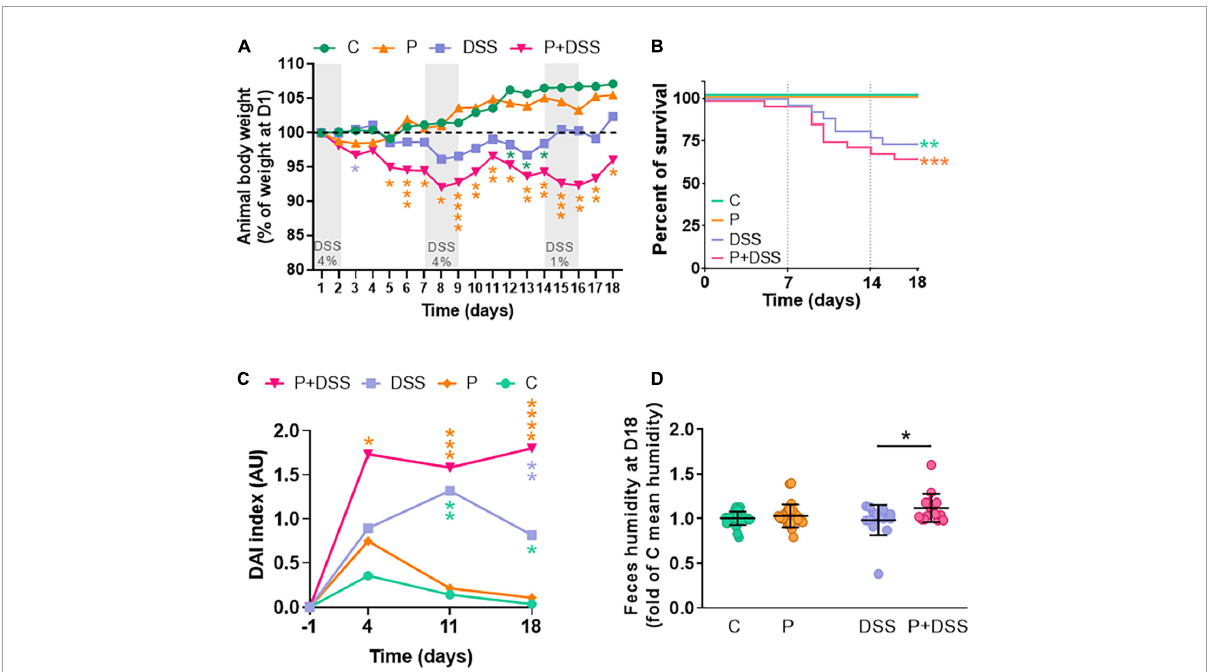
FIGURE1 Prebiotic administration to mothers sensitises their offspring to colitis. Impact of prebiotic administration to mothers was measured in offspring during and at the end of a protocol of colitis induction by dextran sulphate sodium (DSS) in all groups of mice. Pups of mothers fed with a standard diet were administered DSS (in blue) or left untouched (in green). The same procedure was followed for pups of mothers fed a diet enriched with prebiotics (P + DSS in pink, P in orange). (A) Weight curves of the animals, where the weight was normalised as per the weight on the first day of DSS treatment (D1) for each mouse. N = 28–30 mice/group. (B) Survival curves of mice. N = 26–30 mice/group. (C) DAI was measured before (D-1) and on D4, D11, D18 of the protocol. N = 29–30 mice/group. (D) Faeces humidity for each mouse. N = 16–28 mice/group. Data represent the mean and standard deviation of the mean. Log-rank test for the survival rate or two-way analysis of variance (ANOVA), followed by Bonferroni’s post hoc comparisons tests: * p < 0.05, ** p < 0.01, *** p < 0.001, **** p < 0.0001, blue asterisk for P + DSS vs. DSS, orange for P + DSS vs. P, and green for DSS vs. C